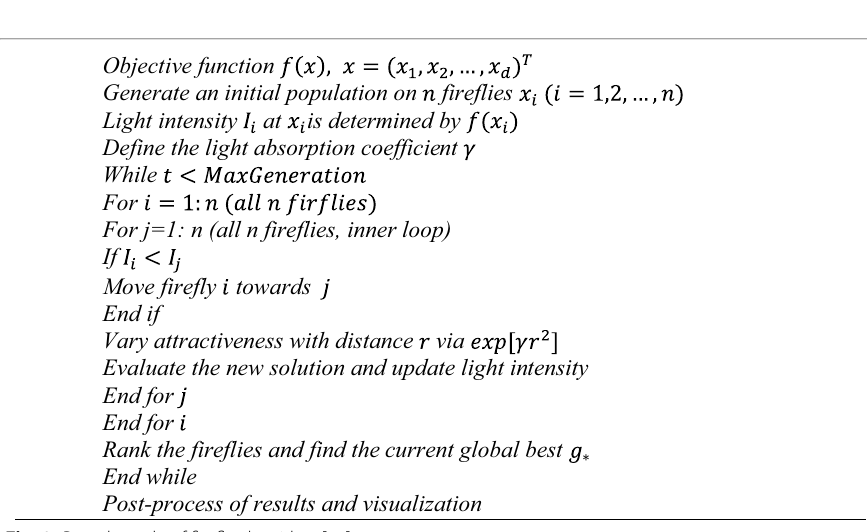
Fig. 2 Pseudo code of firefly algorithm